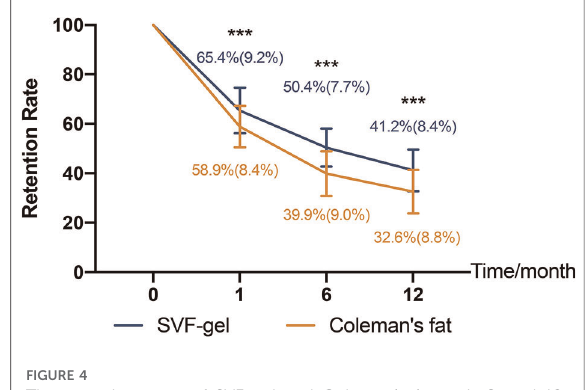
FIGURE 4 The retention rates of SVF-gel and Coleman ’ s fat at 1, 6, and 12 months